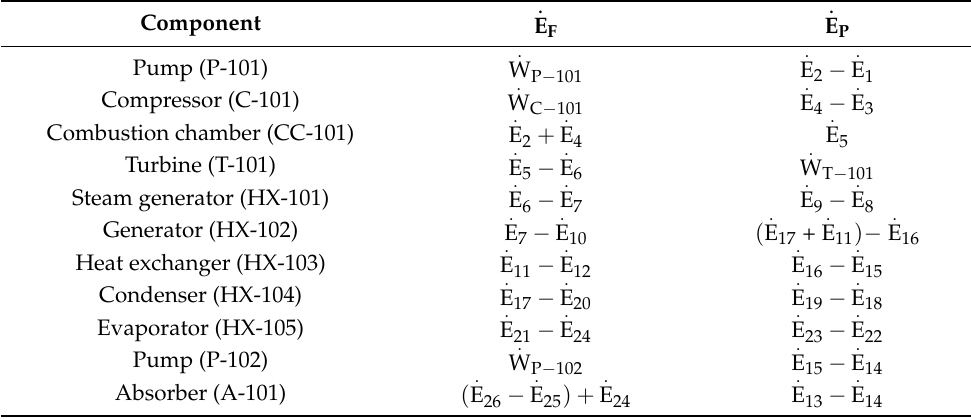
Table 2. Definitions of fuel and product exergy for the system components.